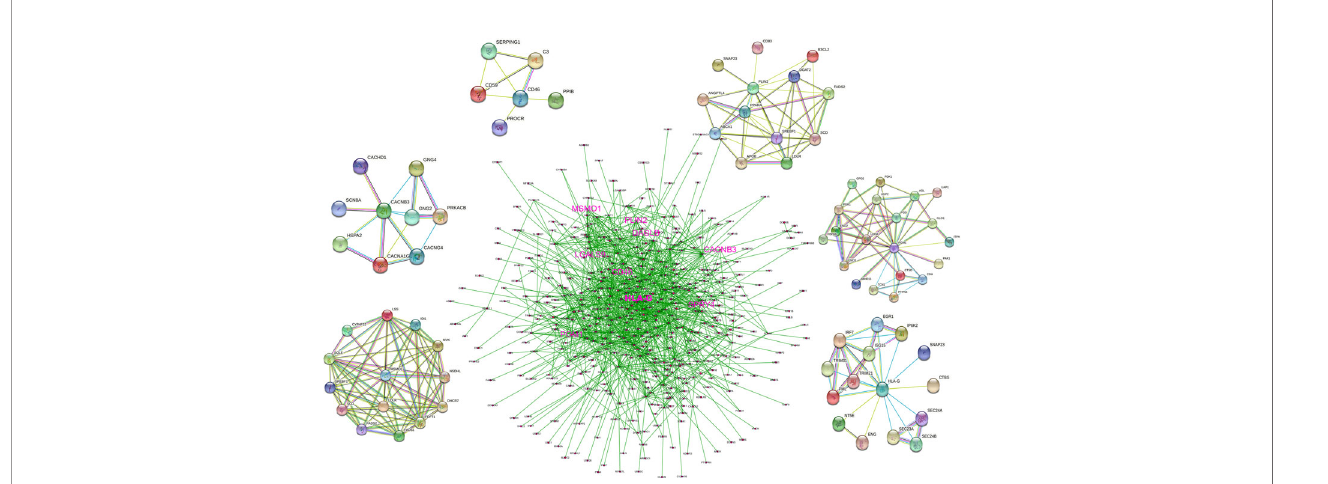
FIGURE 4 | PPI network based on the data from STRING